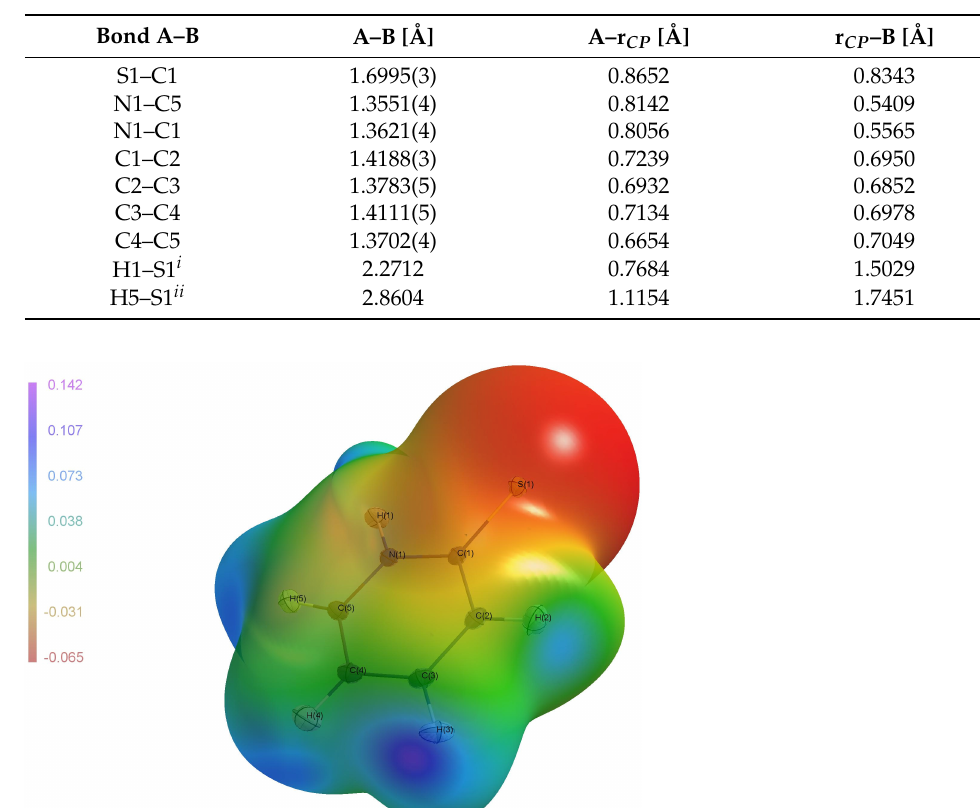
Table 6. Locations of the bond critical points r CP in (I) . Symmetry codes i : − x ,1 − y , − z ; ii : x − 1, y , z .